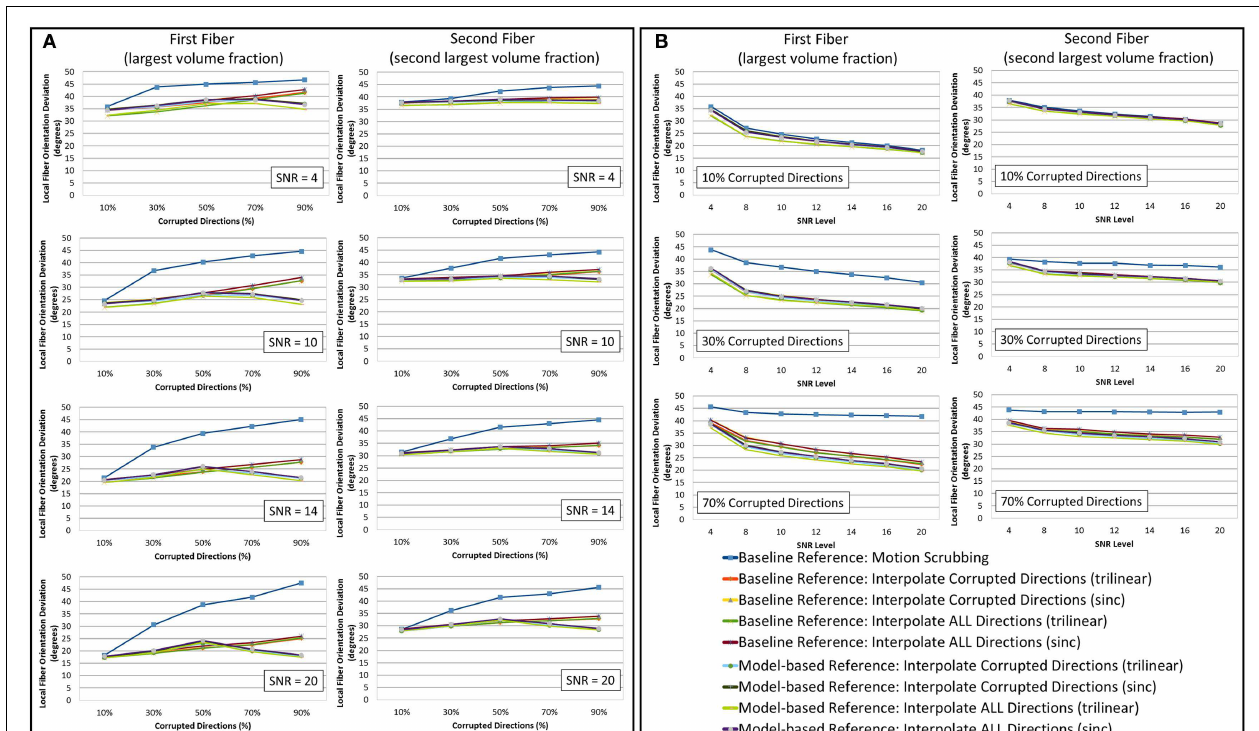
for the first detected fiber having the largest volume fraction while the second and fourth columns show such values for the second detected fiber having the second largest volume fraction. Notice that local fiber orientations are more affected by motion scrubbing as SNR decreases and/or corrupted directions